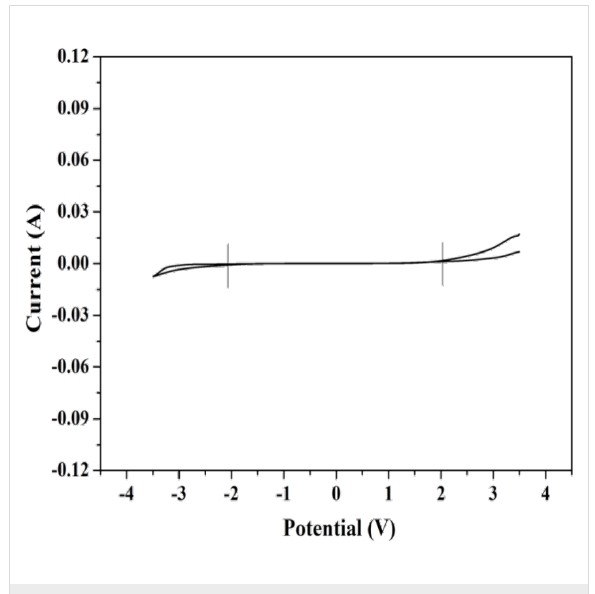
Figure 10: Linear sweep cyclic voltammetry curve of polymer gel elec- trolytes (cell stainless steel | polymer gel electrolyte | stainless steel) recorded at room temperature at a scan rate of 5 mV·s − 1